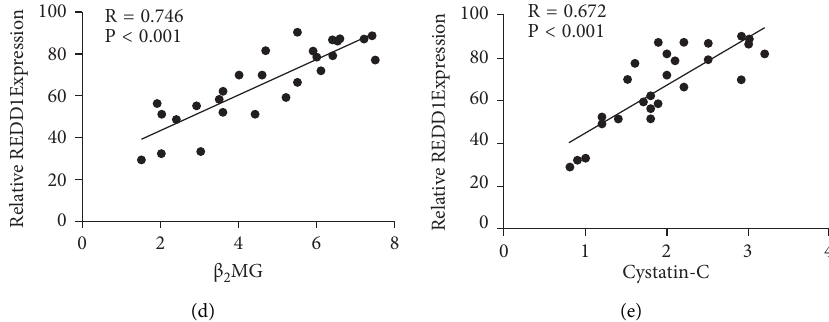
Figure 1: Expression of REDD1 in the kidneys of patients with DN and the correlation analysis of REDD1 with clinical indicators. (a) Immunohistochemical staining analysis of the expression of REDD1 in diabetic nephropathy biopsies (scale bar, 100 μ m, n Correlation between Scr and the expression level of REDD1 in DN patients ( n score ( n 40). (d, e) Correlation between β 2MG or cystatin C and the expression level of REDD1 in DN patients ( n (cid:31) expressed as